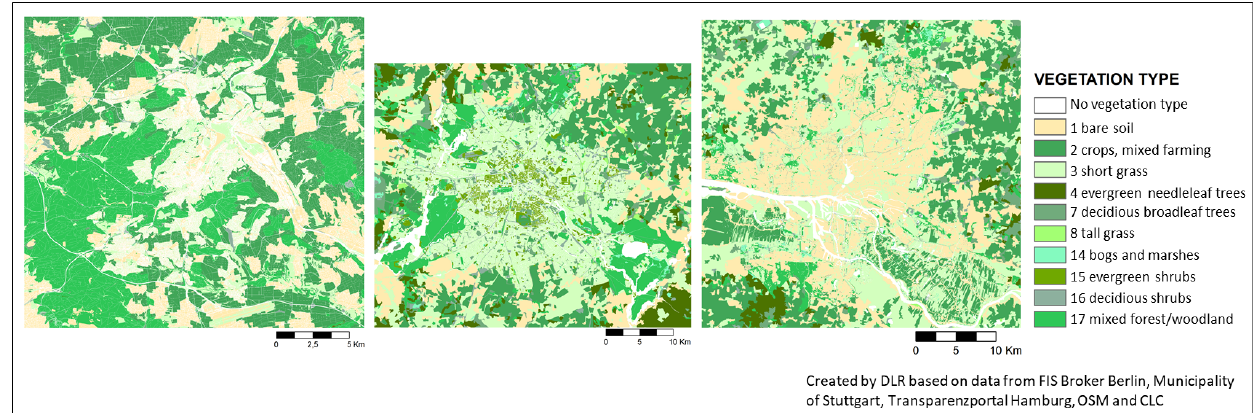
Figure 5. Vegetation type. From left to right: Stuttgart, Berlin and Hamburg. Sources: FIS Broker (dl-de/by-2-0: https://www.govdata.de/ dl-de/by-2-0, last access: 26 October 2020), Municipality of Stuttgart, Freie und Hansestadt Hamburg, Landesbetrieb Geoinformation und Vermessung, European Union (2017) and